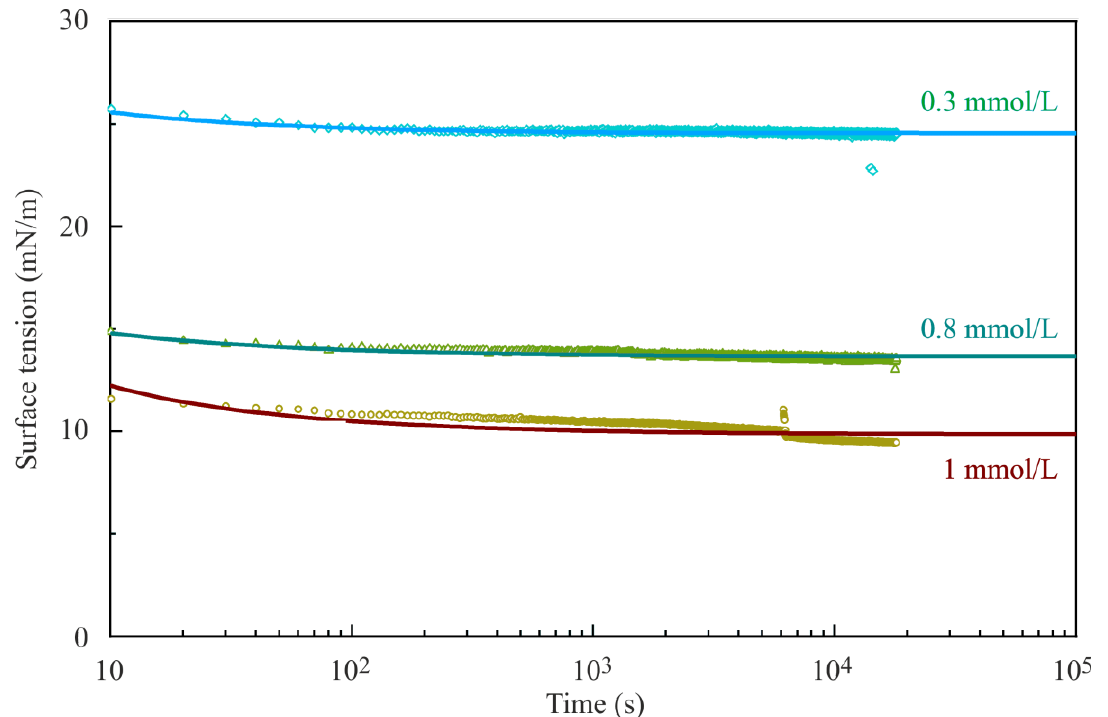
Figure 9. Dynamic interfacial tension of mixed aqueous solutions of NaC 12 SO 4 + C 6 TAB at the water/hexane interface measured by PAT-1; ( (cid:7) ) 0.3 mmol/L, ( ) 0.8 mmol/L, ( • ) 1 mmol/L; solid lines are calculated from the Frumkin and reorientation (see Supplement for the result with the reorientation model) adsorption models, respectively.